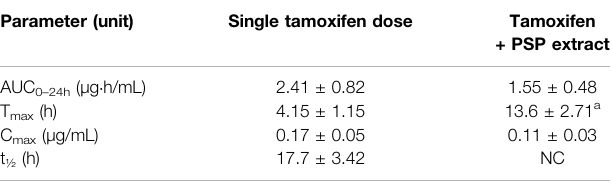
TABLE 1 | Non-compartmental pharmacokinetic parameters of single oral tamoxifen dose (20 mg/kg on day 8) with/without PSP extract (340 mg/kg orally for 7 days prior) in female Sprague-Dawley rat serum. Data was expressed as mean ± SEM ( n =